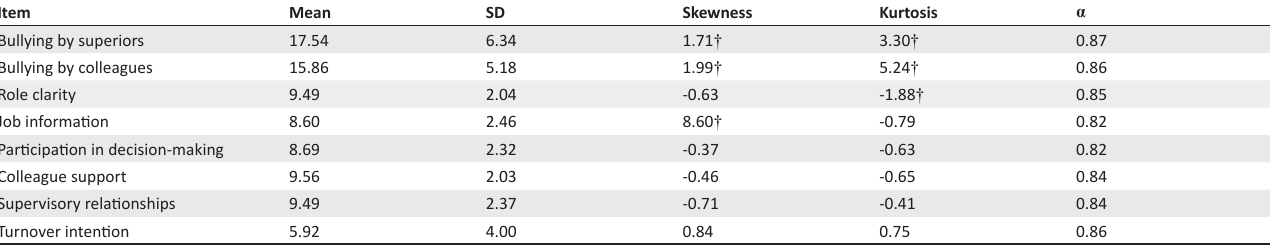
TABLE 2: Descriptive statistics, Cronbach alpha coefficients and correlation coefficients of the SAEHWS. Item